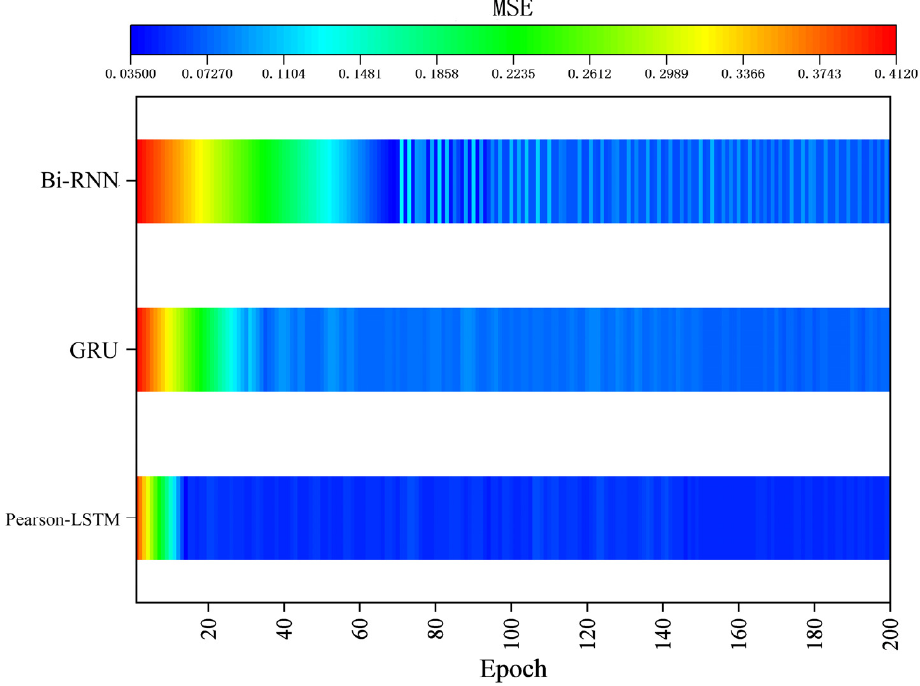
Figure 8. Loss comparison for the three models.